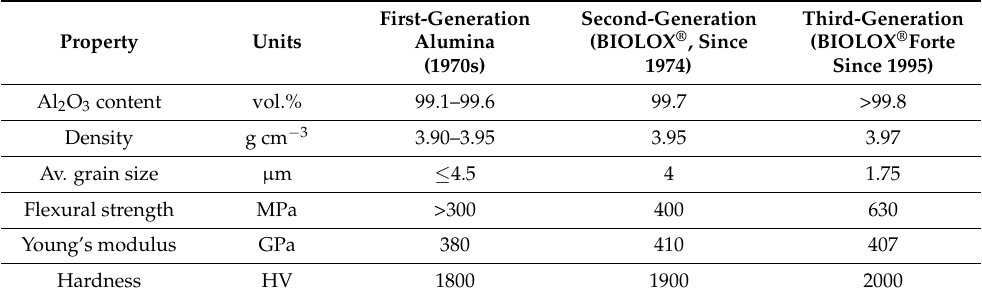
Table 1. Selected properties of alumina, evidencing the development of the material [5]. Property Units